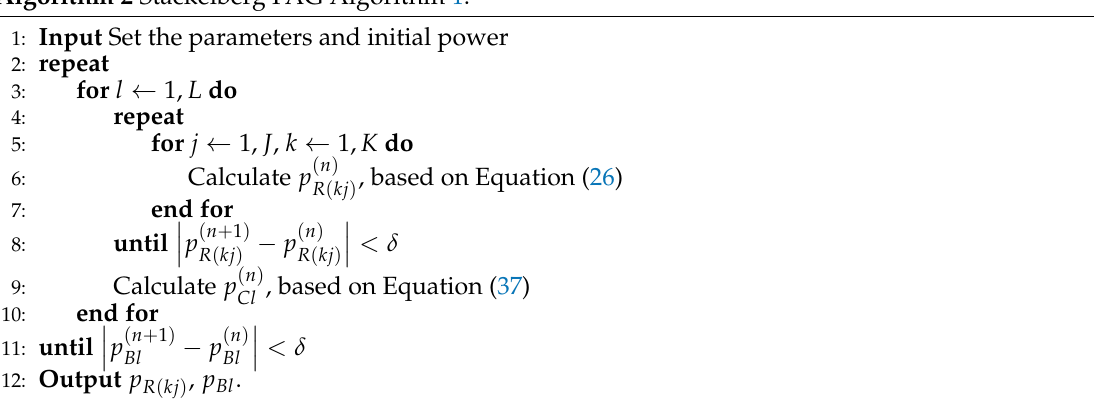
Algorithm 2 Stackelberg PAG Algorithm